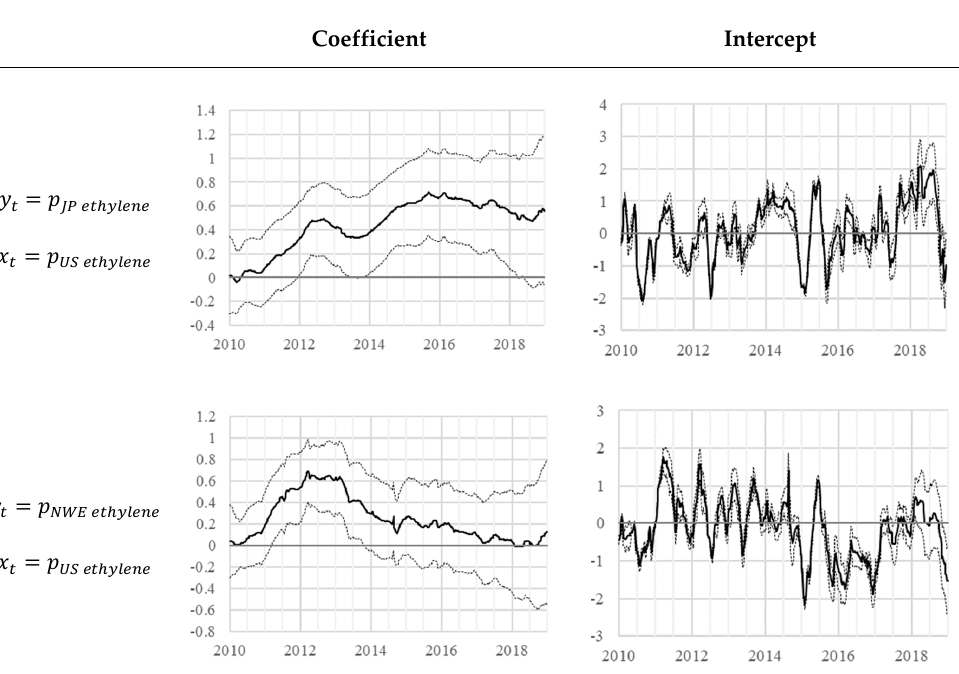
Figure 4. Time-varying coefficients and intercepts in cointegration equations. Table 8. Unit-root test results (Z-statistic) on residuals of the time-varying cointegration equations. Region ADF PP